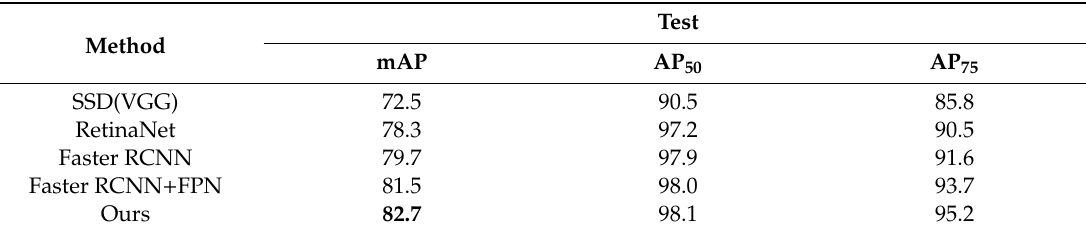
Table 3. Comparison of the di ff erent methods on the test dataset.